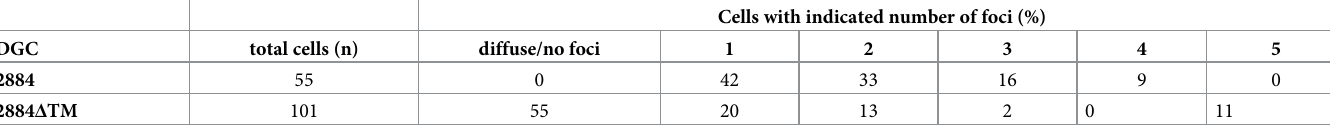
Cells with indicated number of foci (%)